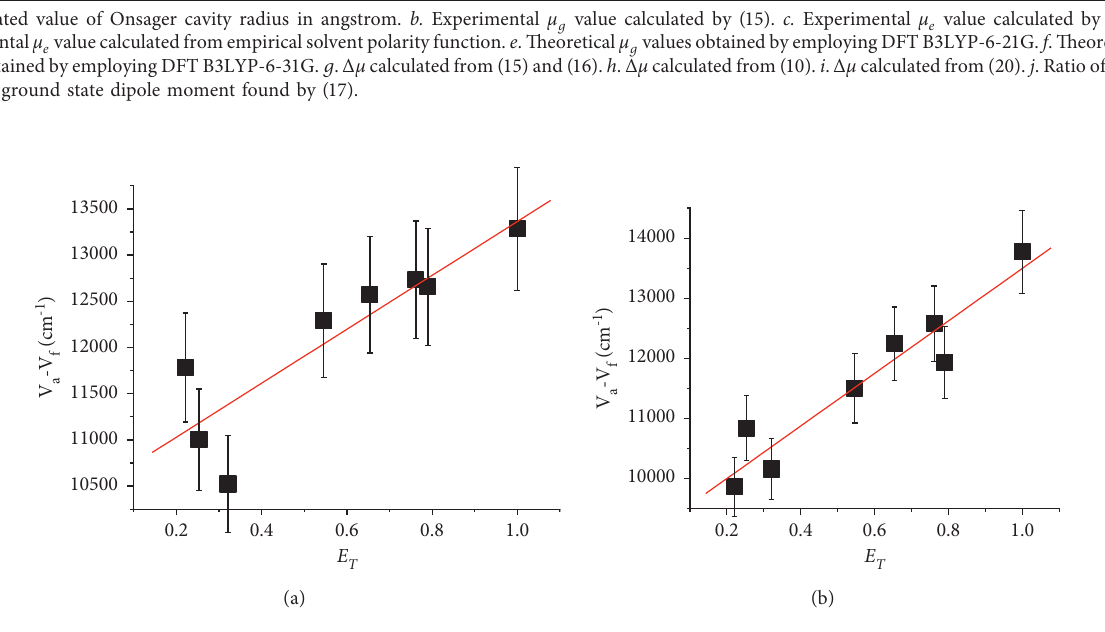
Figure 6: Plot of ] − ] E N a f versus T for Reichardt equation, (a) LVF in different solvents (chloroform, dichloromethane, isopropanol, ethanol, methanol, distilled water, ethyl acetate, and ethyl glycol) and (b) NRF in different solvents (chloroform, dichloromethane, isopropanol, ethanol, methanol, distilled water, ethyl acetate, and ethyl